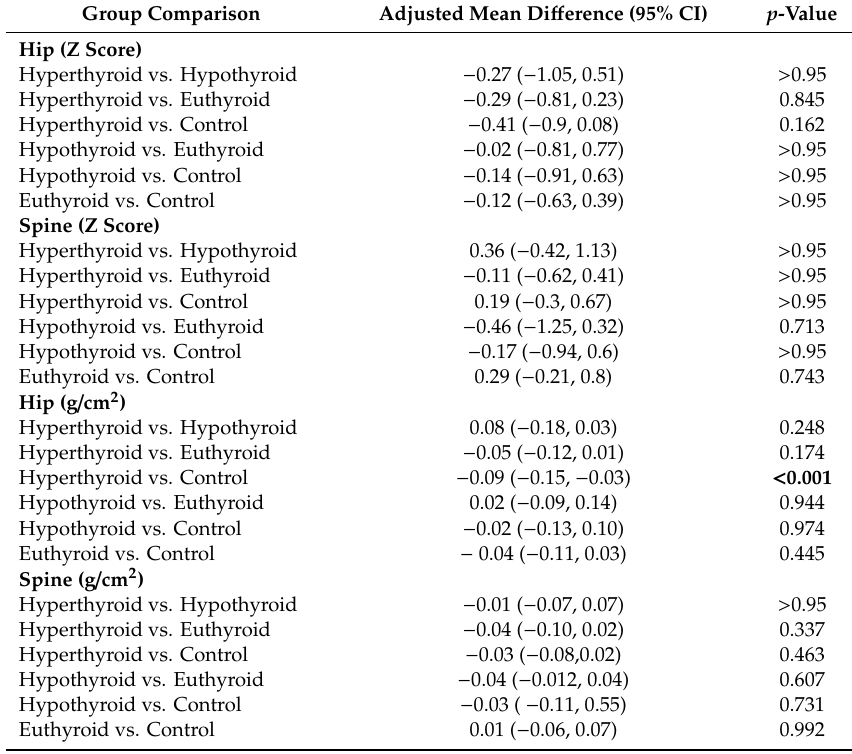
Table 13. Pairwise comparison of Z score and bone density (g / cm 2 ) of hip and spine among groups (ANOVA). Multiple comparisons using Bonferroni method.